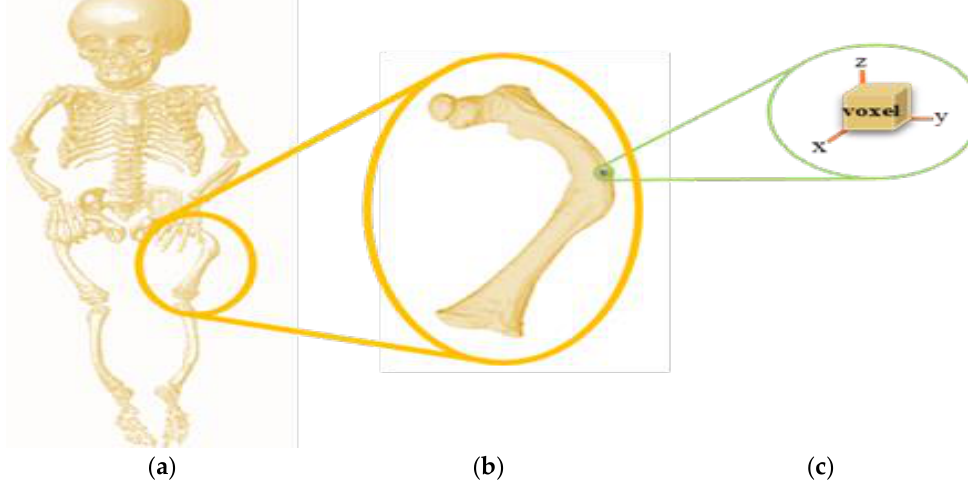
Figure 2. Determination of a voxel: ( a ) processing of all DICOM ® files; ( b ) selection of the tomo- graphic slices corresponding to the femur; ( c ) delimitation of the minimum unit of a tomography.